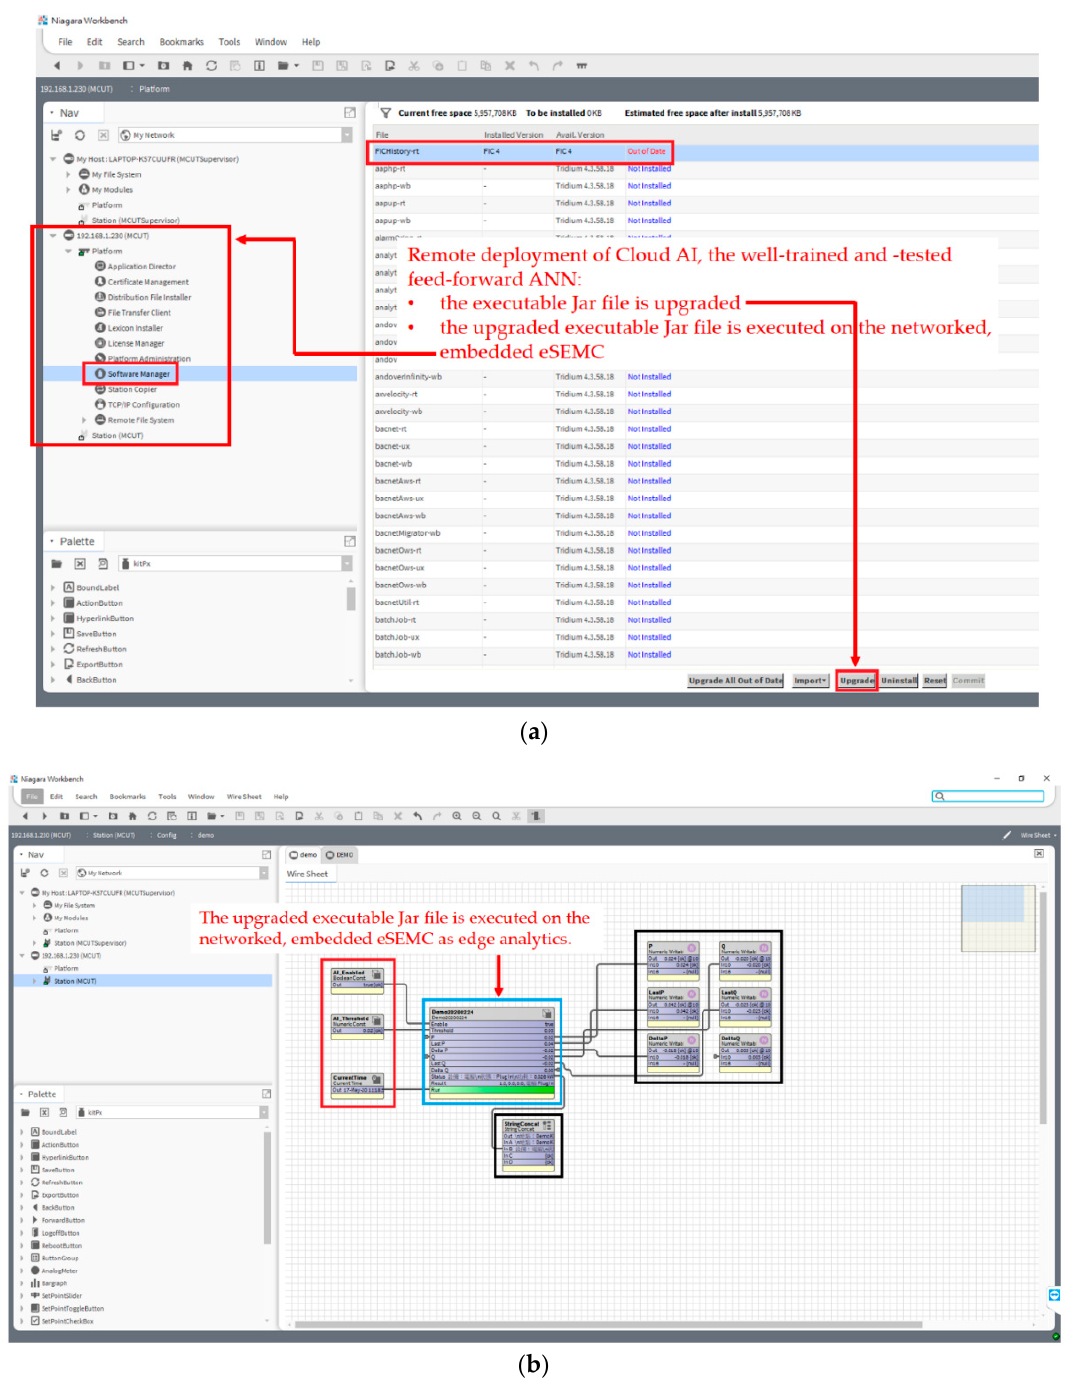
Figure 10. Remote deployment of the well-trained and -tested feed-forward ANN in cloud computing: ( a ) An executable Jar (Java ARchive) file was upgraded; ( b ) the upgraded executable Jar file is executed on the networked, embedded eSEMC as Edge AI.